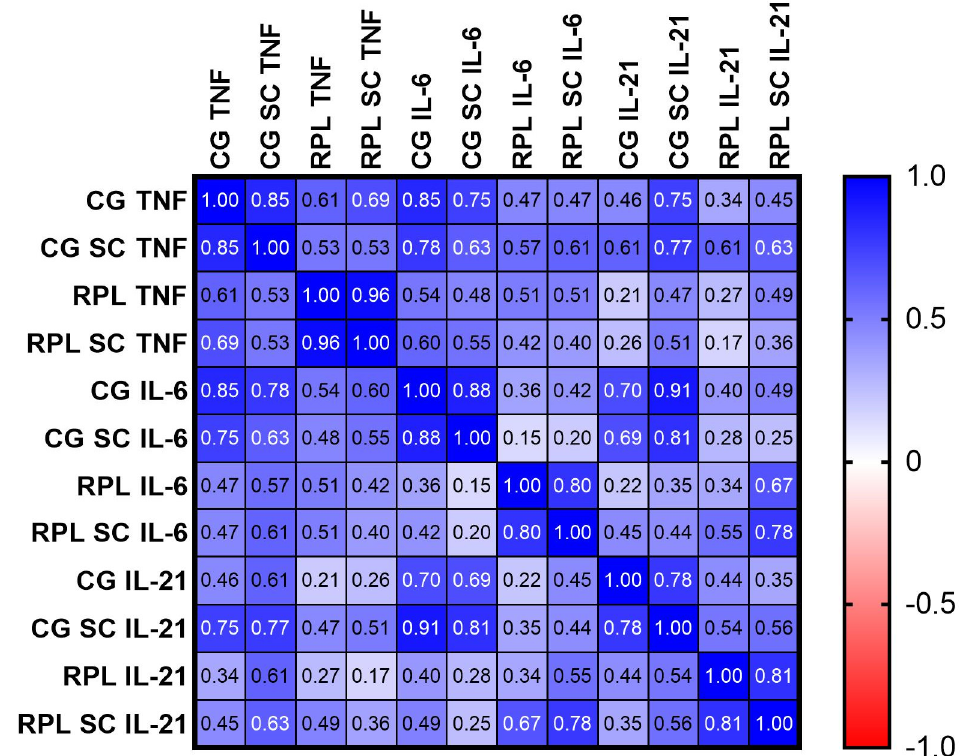
Figure 3. Pearson’s “r” factor correlations between inflammatory cytokines. Blue colors stand for a positive correlation r > 0, red colors r < 0. The graphs showing the correlation between particular cytokines: IL6 vs. TNF, IL-21 vs. TNF, IL-6 vs. IL-21 in CG and idiopathic RPL are shown in supplementary data, (CG—control group, n = 20; RPL—study group, n = 21; SC—sildenafil citrate).